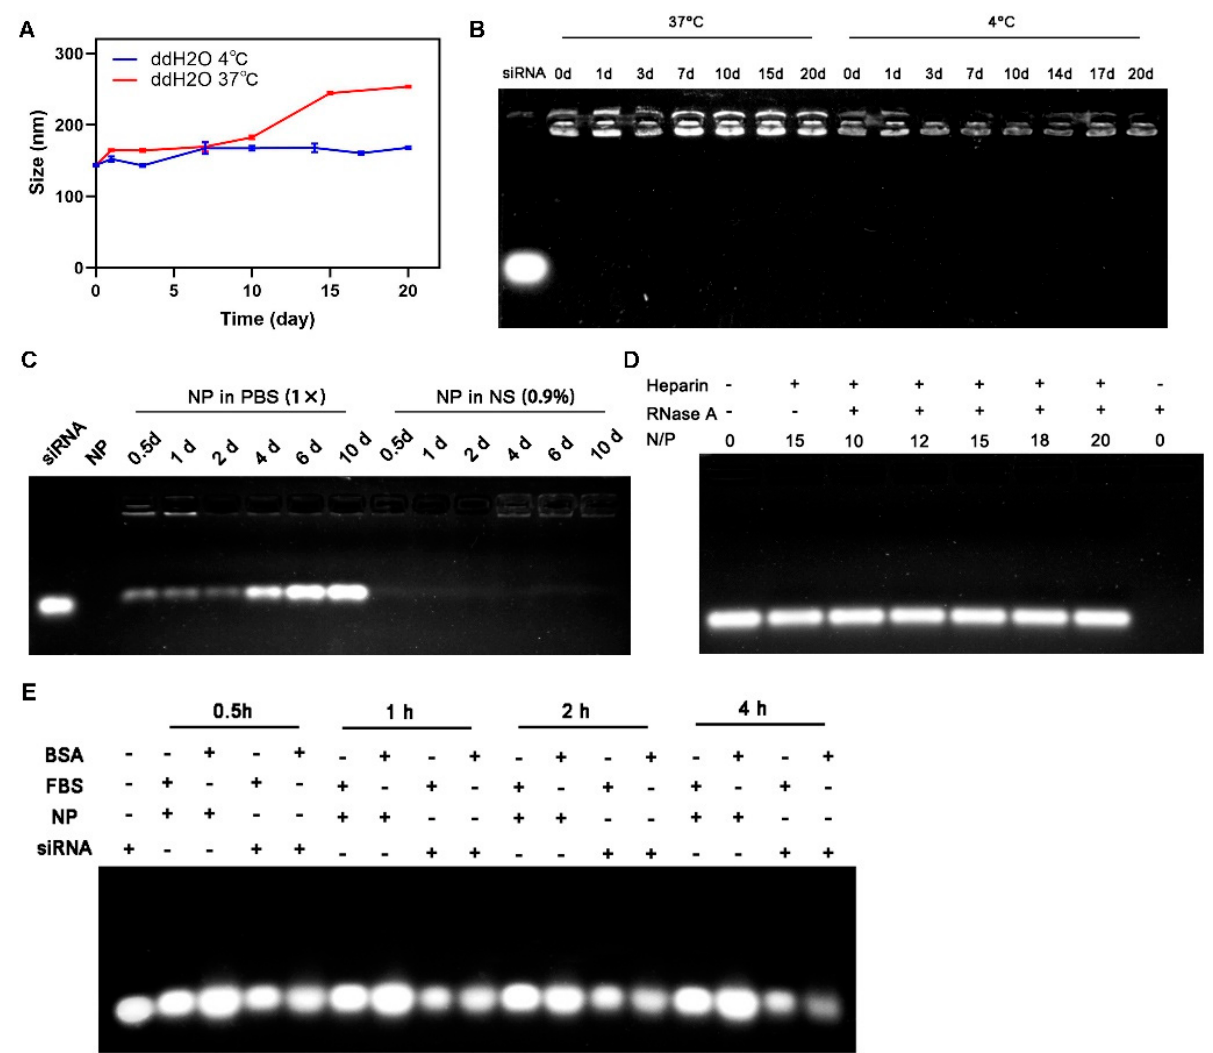
Figure 2. Stability of Chol-es-Lys/siRNA nanocomplexes. Storage stability of Chol-es-Lys/siRNA nanocomplexes (N/P = 15) evaluated by ( A ) average sizes and ( B ) agarose gel electrophoresis. ( C ) Stability of Chol-es-Lys/siRNA nanocomplexes (N/P = 15) in salt solutions. ( D ) RNase protection assay of Chol-es-Lys/siRNA nanocomplexes (N/P = 10, 12, 15, 18, 20). ( E ) Serum stability assay of Chol-es-Lys/siRNA nanocomplexes (N/P = 15) in 10% FBS or 10% BSA. NS, normal saline; FBS, fetal bovine serum; BSA, bull serum albumin; NP, referred to Chol-es-Lys/siRNA nanocomplexes.